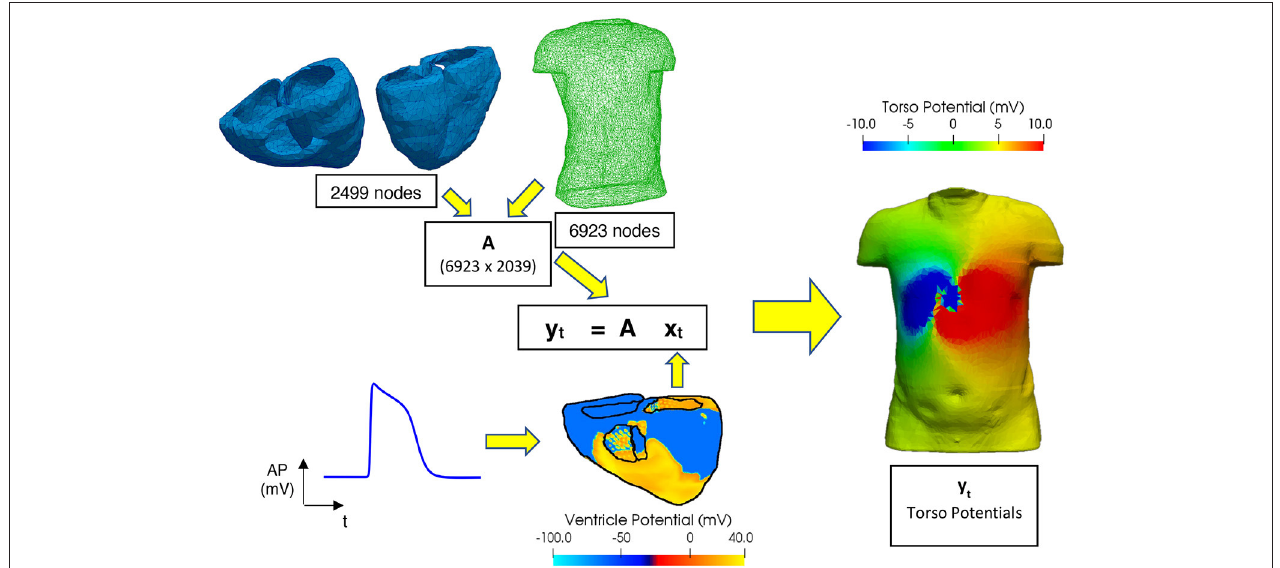
FIGURE 1 | Workflow for performing the forward problem. Transfer matrix (A) constructed using a 6,923-node male torso geometry and 2,499-node ventricle geometry, x t and y t are matrices filled with the epicardial ventricular potentials and torso potentials at each time t, respectively. Ventricular electrical excitations were simulated using a biophysically accurate 3D computer model of the human ventricles (Ni, 2016). The electrical action potentials on the epicardial surface are extracted and mapped onto the ventricular mesh representing the epicardial surface. Body surface potentials on the torso are then computed using the boundary element method ( Stenroos and Haueisen, 2008).